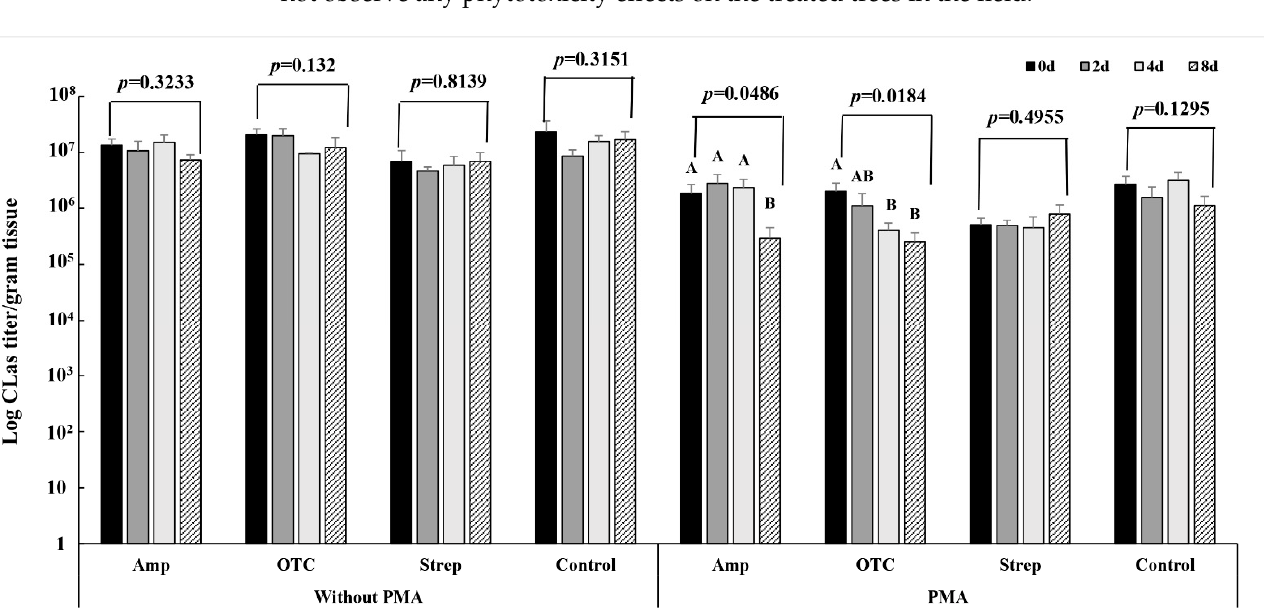
Figure 4. Assessing antibacterial activity of chemical compounds (Amp, OTC, Strep, and water con ‐ trol) against CLas via PMA ‐ qPCR in HLB ‐ affected citrus cutting assays. Significant differences be ‐ tween time points are indicated by * p ≤ 0.05 and ** p ≤ 0.01. Standard error of the mean is indicated by a vertical line.